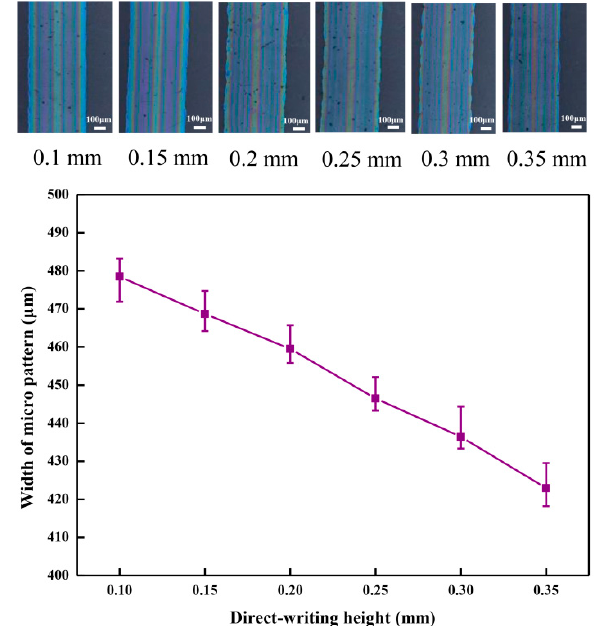
ff ect of the direct-writing height on the organic micro pattern Figure 6. Effect of the direct-writing height on the organic micro pattern width. Figure 6. E